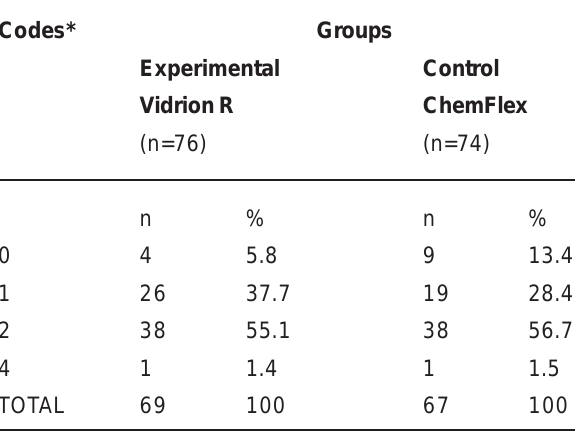
*Success: 0, 1 and 2; Failure: 3, 4 and 5